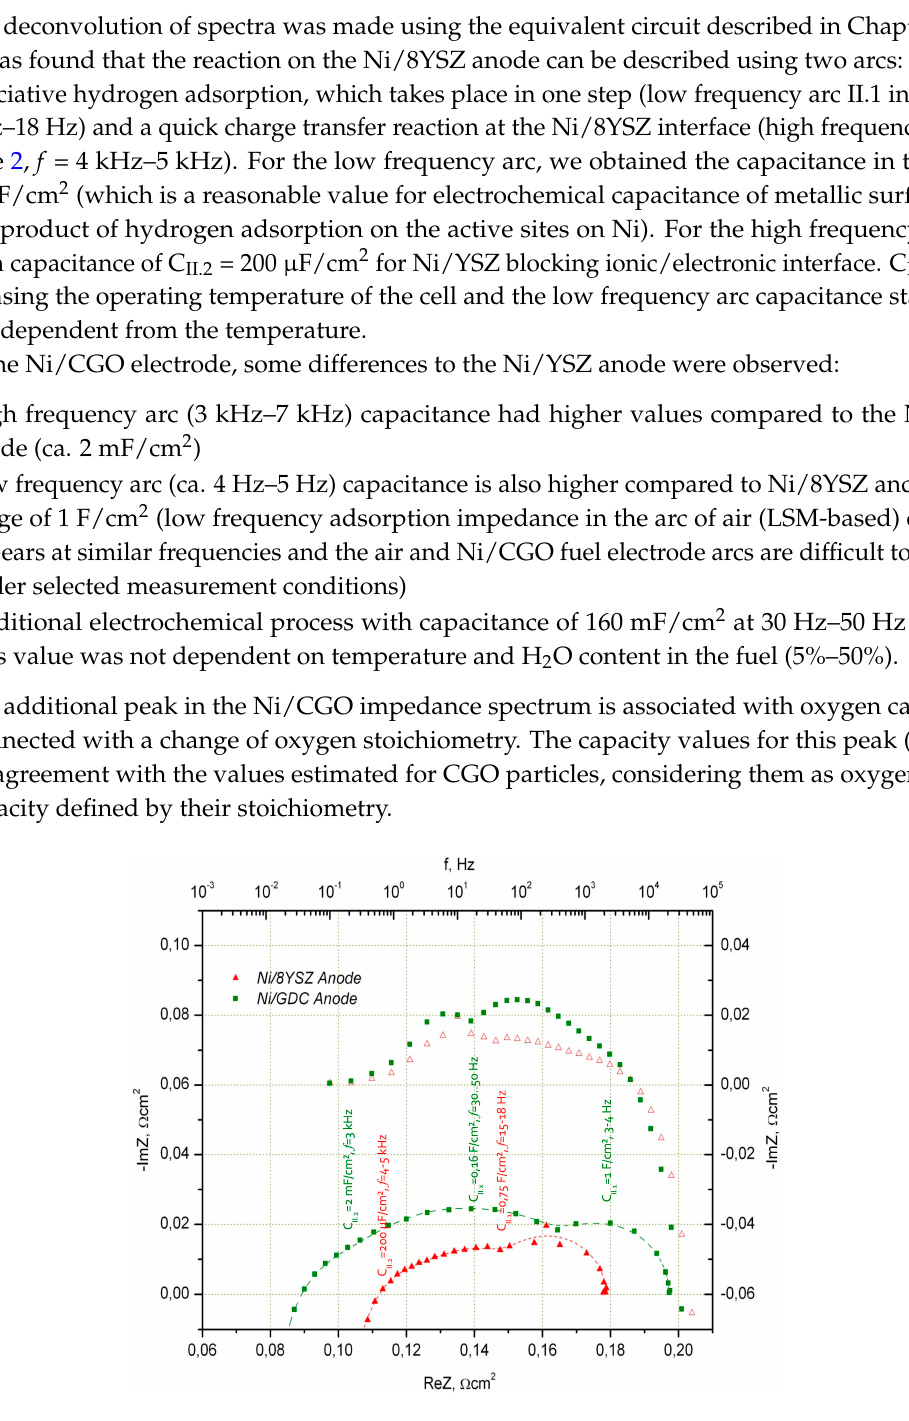
Figure 2. Impedance spectra of MEAs with the LSMM’/10Sc1CeSZ cathode and the Ni/YSZ and Ni/CGO anode at 850 °C with air as oxidant and H 2 :H 2 O = 50:50 as fuel.